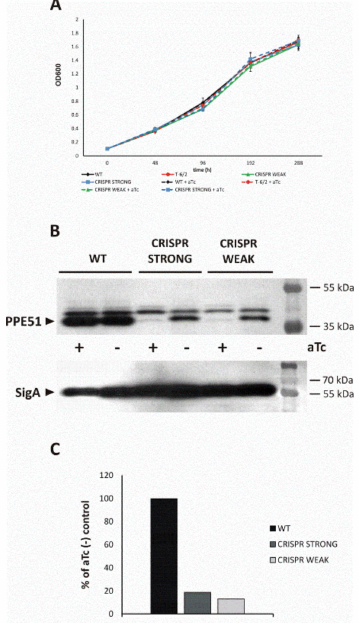
Figure 2. Depletion of PPE51 does not a ff ect the growth of Mtb Growth kinetics ( A ) of the wild-type (black) strain and the T-6 / 2 (red), PPE51 CRISPR-weak (green) and PPE51 CRISPR-strong (blue) mutants of M. tuberculosis in 7H9 / OADC medium, supplemented (dashed lines) or not (solid lines) with aTc. ( B ) Immunodetection of PPE51 and control SigA proteins in the cell lysis of wild-type M. tuberculosis (lines 1–2) and CRISPR mutants (CRISPR-weak, lines 3–4; CRISPR-strong, lines 5–6) grown in rich medium supplemented or not with aTc, with rabbit anti-PPE51 (upper panel) and anti-SigA (bottom panel) serum. ( C ) Densitometry analysis of bands representing PPE51 normalized to the control SigA